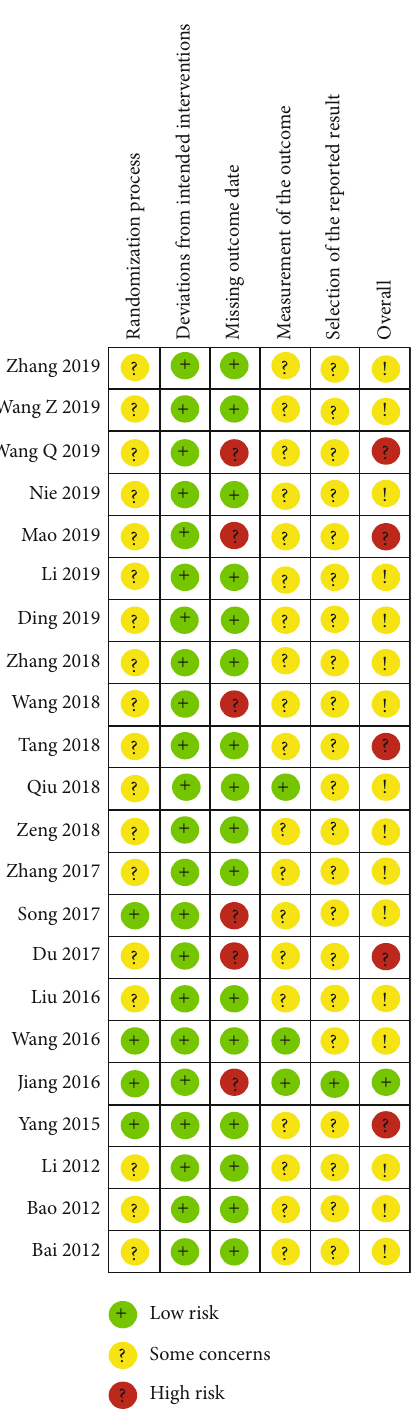
Figure 2: Risk of bias assessment for included studies.